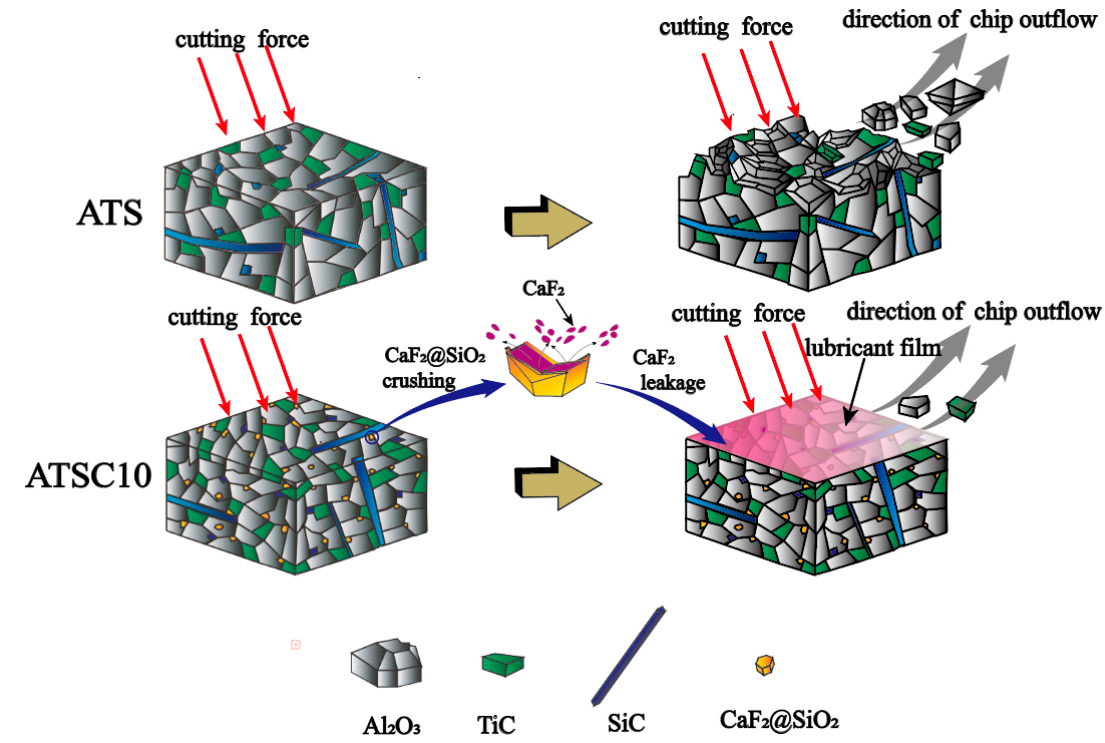
Figure 13. Comparison of the cutting mechanisms of ATS and ATSC10 cutting tools.